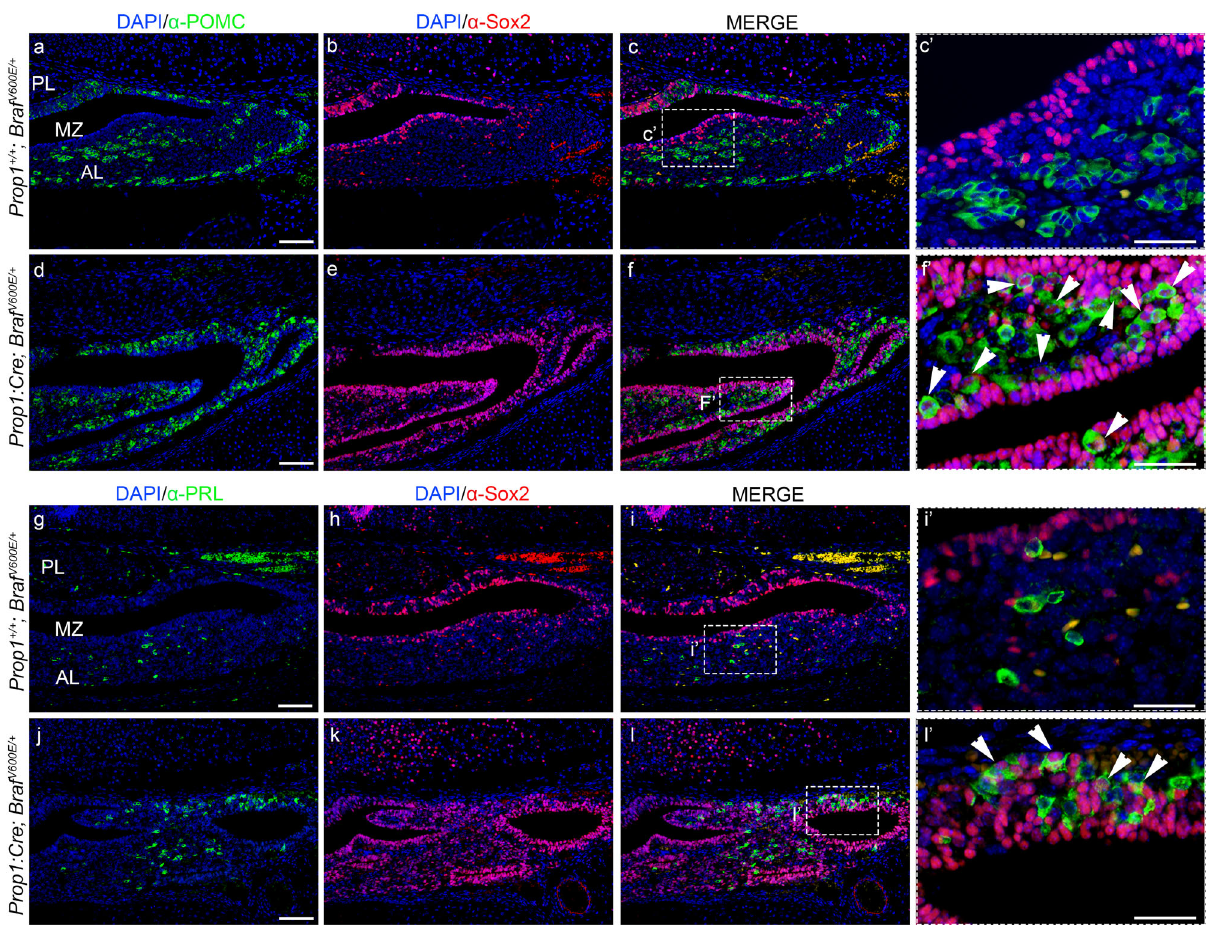
Fig. 5 Activation of the ERK/MAPK results in increased expression of POMC and PRL with a portion of Sox2 + ve progenitor/stem cells co-expressing POMC and PRL. Double immuno fl uorescence (IF) against POMC (green, a – f ), PRL (green, g – l ) and Sox2 (red, a – l ) on coronal sections of E18.5 Wt pituitaries ( a – c , g – i ) and Prop1:Cre;Braf V600E/ + ( d – f , j – l ). The Prop1:Cre;Braf V600E/ + mutant pituitaries ( d ) exhibit a higher number of POMC + ve cells compared to Wt ( a ). Enlarged merged images of the marginal zone revealed co-expression of Sox2 and POMC within a portion of POMC + ve cells (white arrowheads in f ′ ). Increase in number of PRL + ve cells was observed in the Prop1:Cre;Braf V600E/ + pituitaries ( j ) compared to Wt ( g ). i ′ and l ′ represent enlarged images of squared areas in i and l , respectively, showing the marginal zone. Cells expressing both Sox2 and PRL were observed in the MZ of the Prop1:Cre;Braf V600E/ + mutant pituitaries (white arrowheads in l ′ ), while no co-expression of Sox2 and PRL was detected in the cells of Wt pituitaries ( I ′ ). Images are representative of four embryos per genotype. AL anterior lobe, MZ marginal zone, PL posterior lobe. Scale bars: a , d , g , j 150 µ m; c ′ , f ′ , i ′ , and l ′ 40 µ